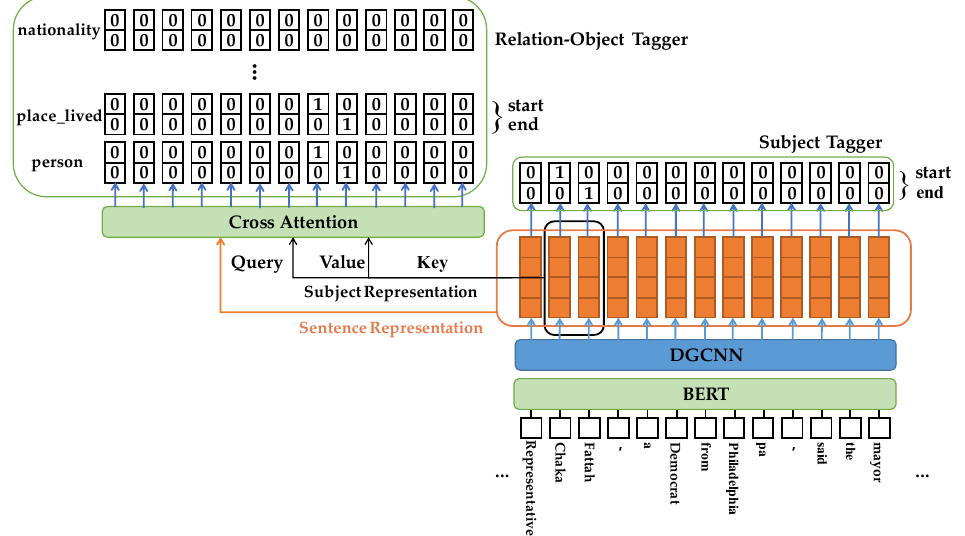
Figure 2. An overview of the RECA model. In this example, “Chaka Fattah” is the subject of this sentence. We tag “1” for “Chaka” in the start position vector and tag “0” for the other words. Similarly, we tag “1” for the word “Fattah” in the end position vector. The RECA model uses an encoder module to convert words into sentence representations and detects the position information of subjects. There are two relational triplets for the subject “Chaka Fattah” in this sentence. Therefore, we tag “1” for the words “Philadelphia” and “pa” in the “place_lived” and “person” relation-object start- and end-position vector. Note that we tag “0” for other relation-object position vectors. The RECA model decodes sentence representation and subject representation and detects the position information of the object for each relation in the relation-object tagger.